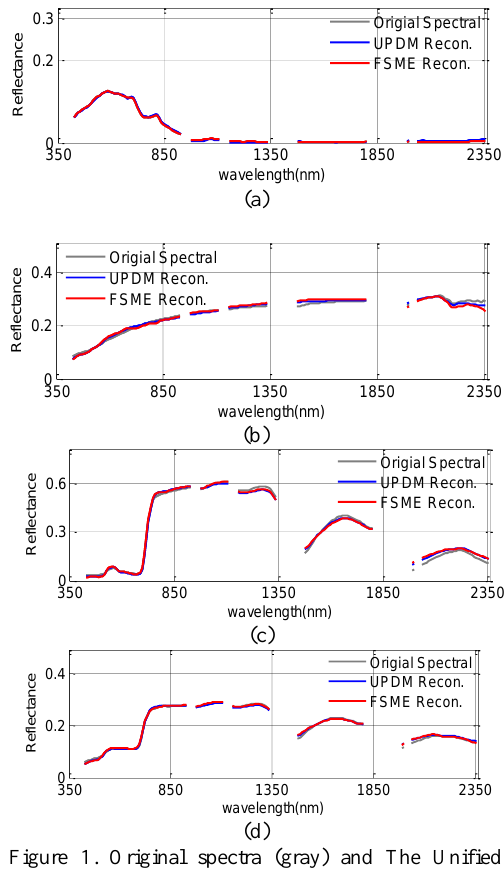
Figure 1. Original spectra (gray) and The Unified Profile for DoDAF and MODAF (UPDM) reconstruction (blue) and Fuzzy Set Multi-Endmember (FSME) reconstruction (red): (a) water (b) soil (c) vegetation (d)